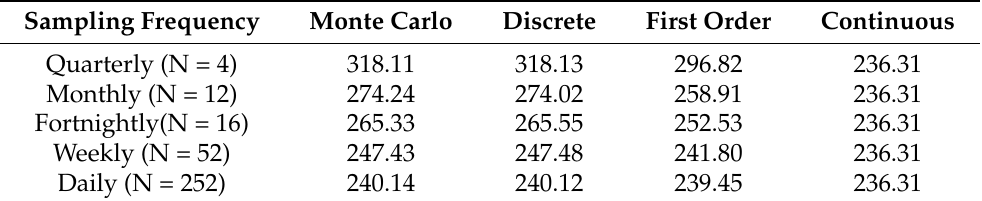
Figure 1. A comparison of fair strike prices based on the closed-solution, Monte Carlo simulations, the first-order approximation and the continuous model. Table 1. The numerical results of Monte Carlo simulations, discrete sampling, first-order approxima- tion and continuous